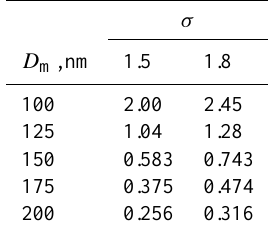
Table 2. Summary of the A(D m , σ ) values shown in Eq. (8) for combinations of the D m and σ values of hydrophobic BC particles.